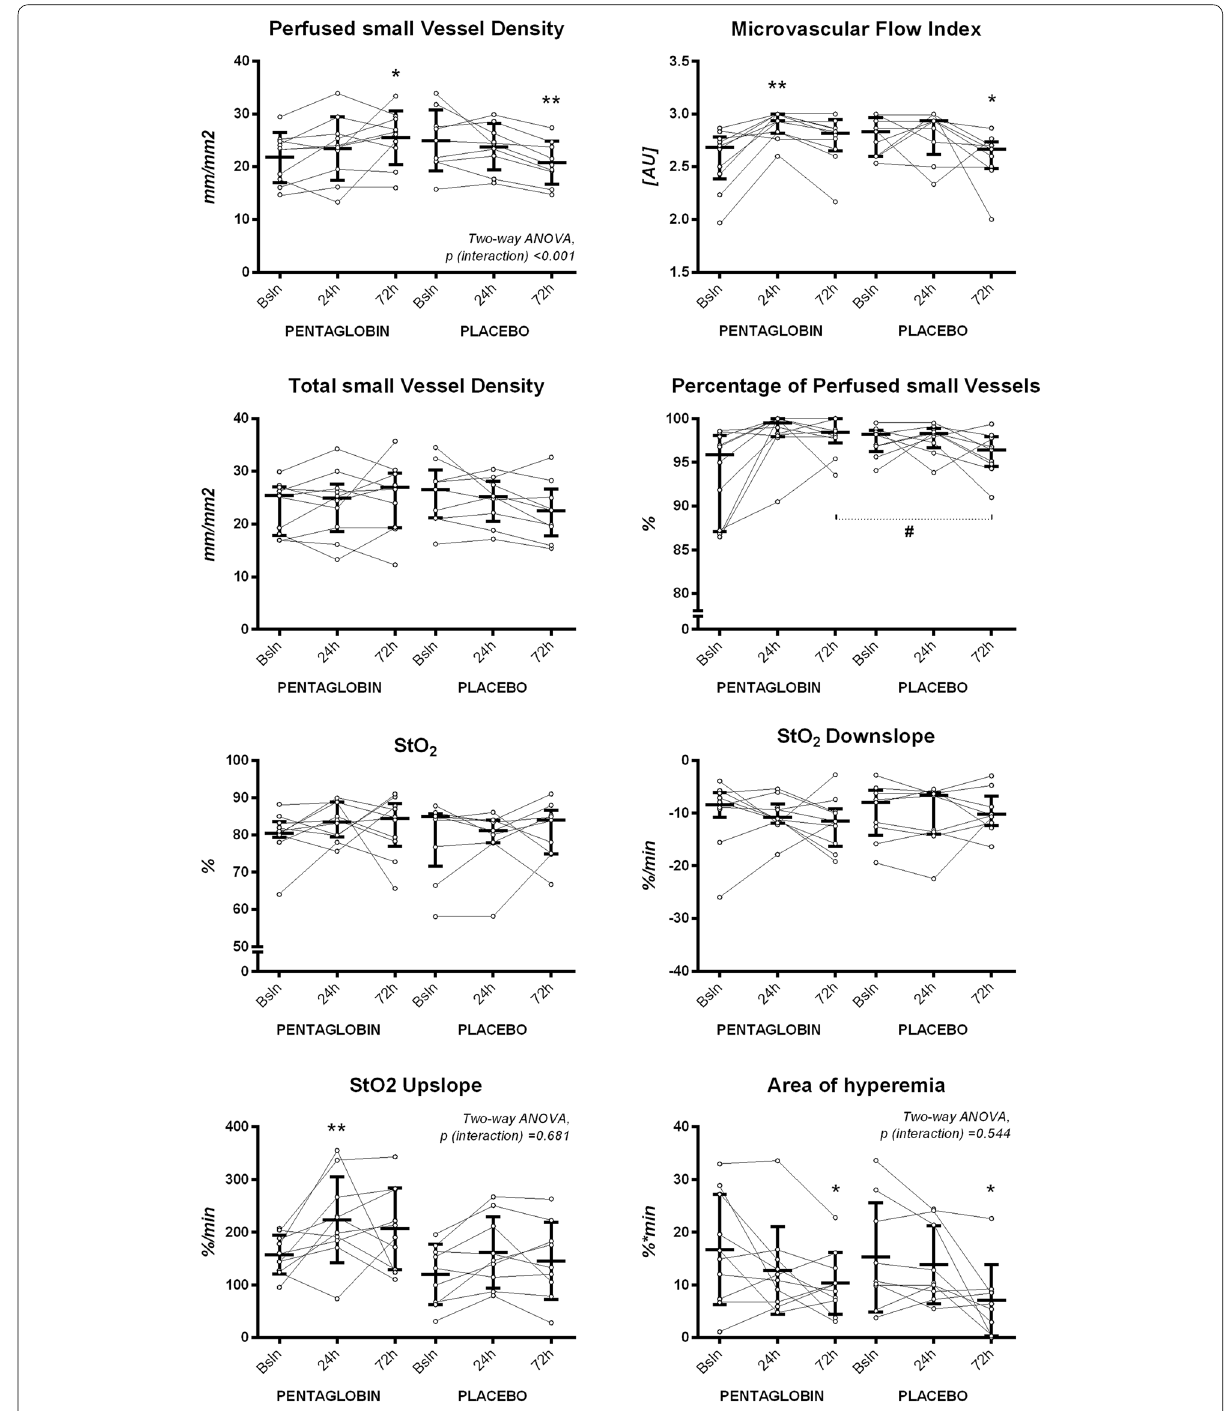
Fig. 2 Comparison of microcirculatory and NIRS-derived parameters. Data are expressed as mean and standard deviation of median [interquartile range]; lines indicate individual changes. * p < 0.05, ** p < 0.01 versus baseline, Two-way ANOVA for repeated measures with Sidack’s post hoc test or Friedman test with Bonferroni post hoc test, as appropriate. # p < 0.05 versus placebo, Two-way ANOVA for repeated measures with Sidack’s post hoc test or Mann–Whitney U test, as